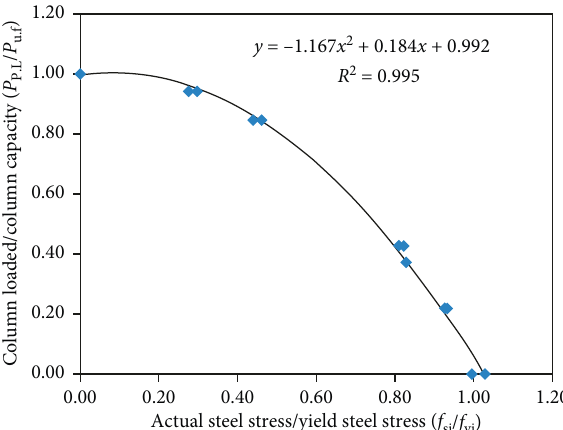
Figure 10: The relation between percentage of preloading columns and the corresponding percentage of steel jacketing stress obtained from the FE